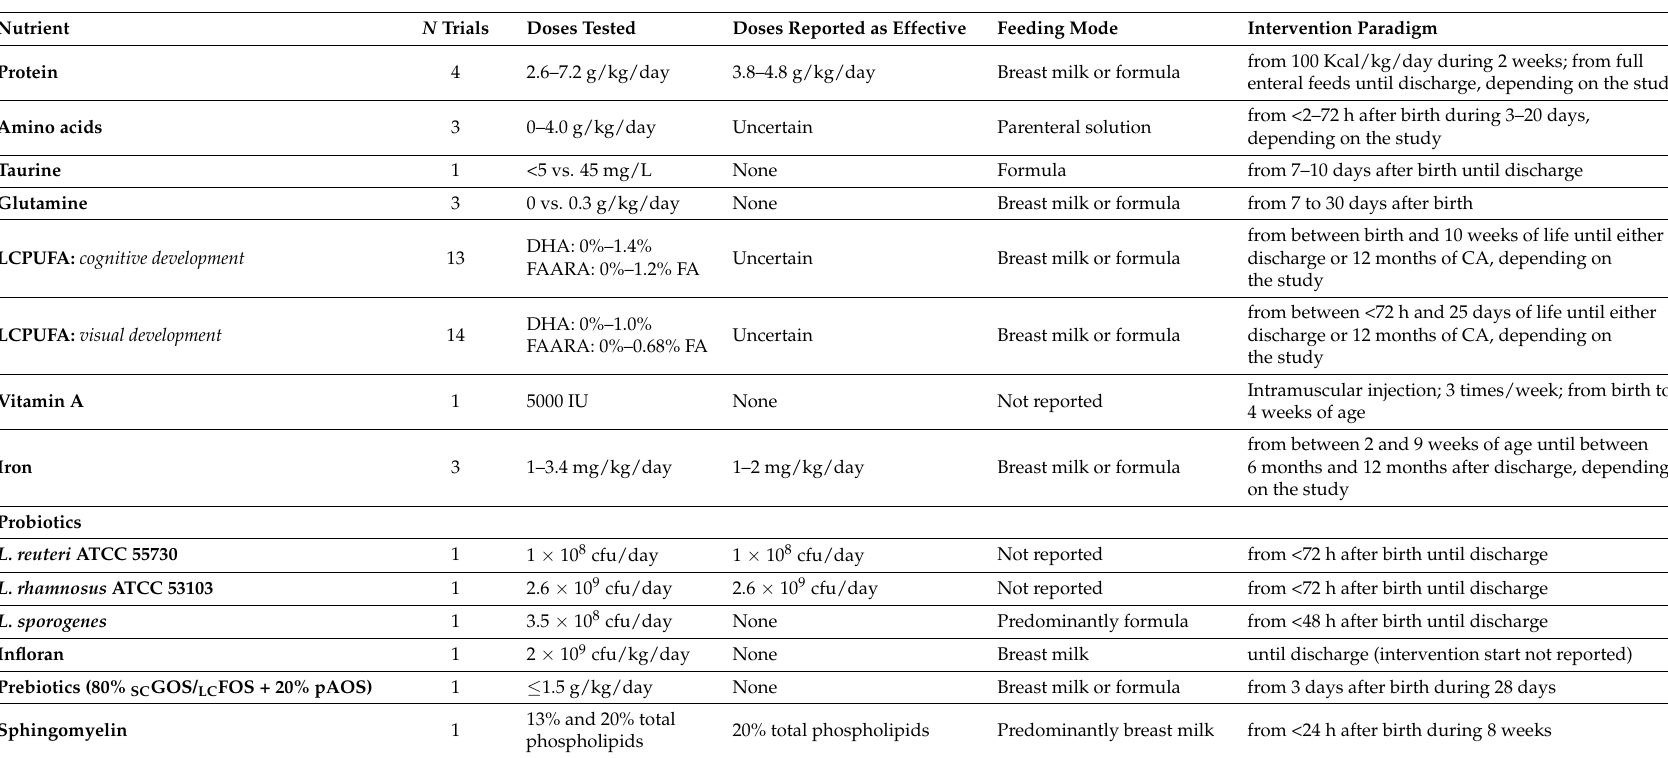
Table 1. Doses, feeding mode and paradigm of interventions with specific nutrients and nutritional supplements for brain and cognitive development in preterm infants Nutrient N Trials Doses Tested Doses Reported as Effective Feeding Mode Intervention Paradigm Protein 4 Breast milk or